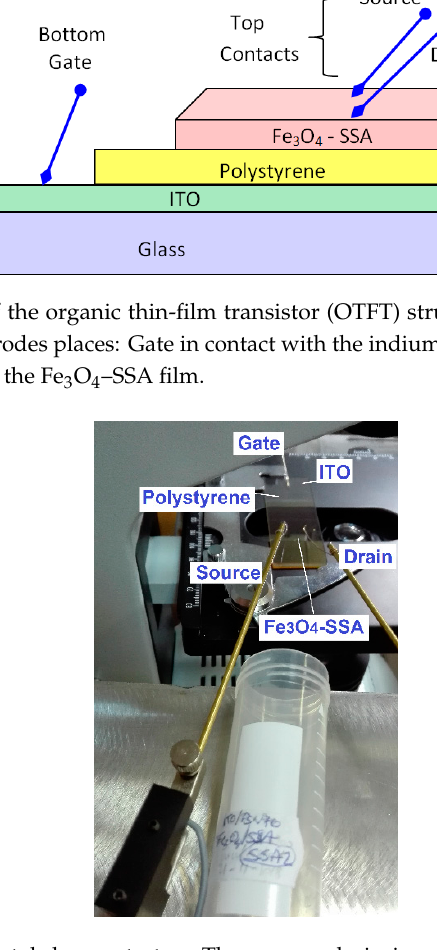
Figure 6. The experimental demonstrator: The source, drain in contact with te Fe 3 O 4 –SSA film (beige-colored), and gate connection to the ITO film. The colorless polystyrene film is longer than the Fe 3 O 4 –SSA film and is shorter than the ITO film, in agreement with Figure 5.